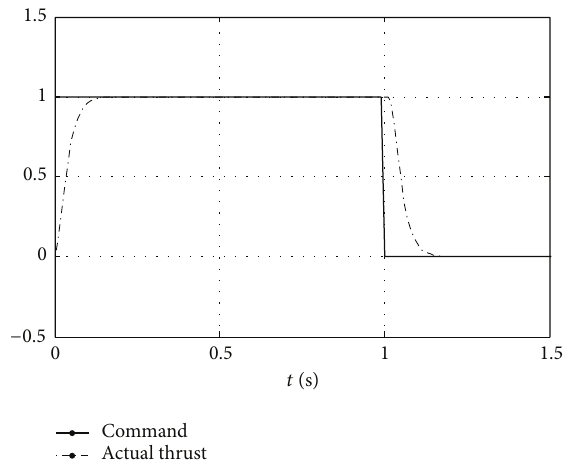
Table 1: Control moments of